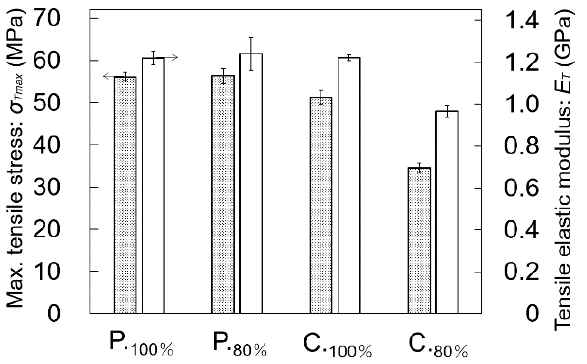
Figure 8. Maximum tensile stresses and tensile elastic moduli of the non-immersed test pieces. Average ± S.D., N = 5.